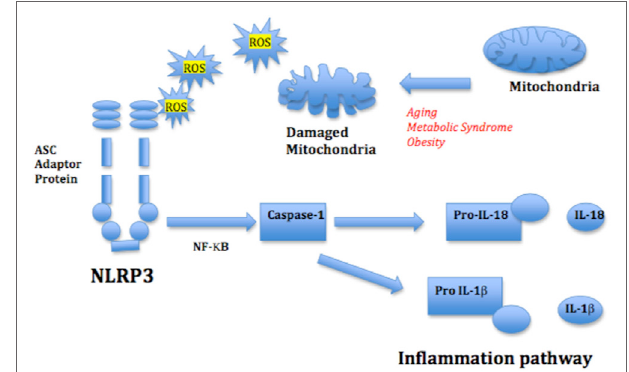
FigURe 4 | Mitochondrial reactive oxygen species (ROS) and nod-like receptor 3 (NLRP3) activation of inflammation pathway. Mitochondrial ROS from damaged mitochondria triggers the inflammasome NLRP3, stimulating NF- κ B and the IL-1 β and IL-18-mediated inflammatory cascade. The adapter protein ASC mediates innate signaling by bridging the interaction between the damage recognition receptor and the NF- κ B caspase-1 inflammasome